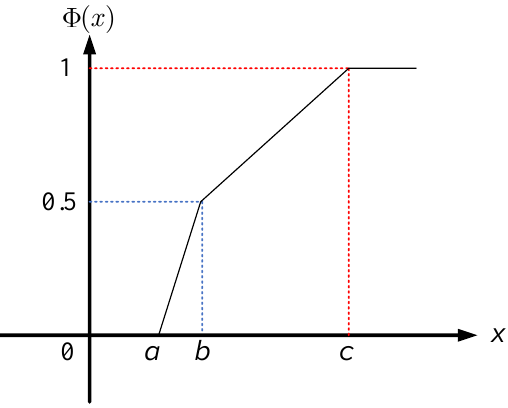
Figure 3. Zigzag uncertainty distribution.